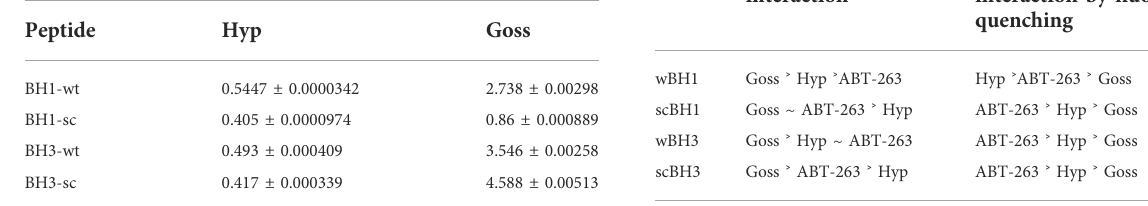
TABLE 2 Comparison of predicted and measured strength of interaction between BH peptides and selected BH3 mimetics.